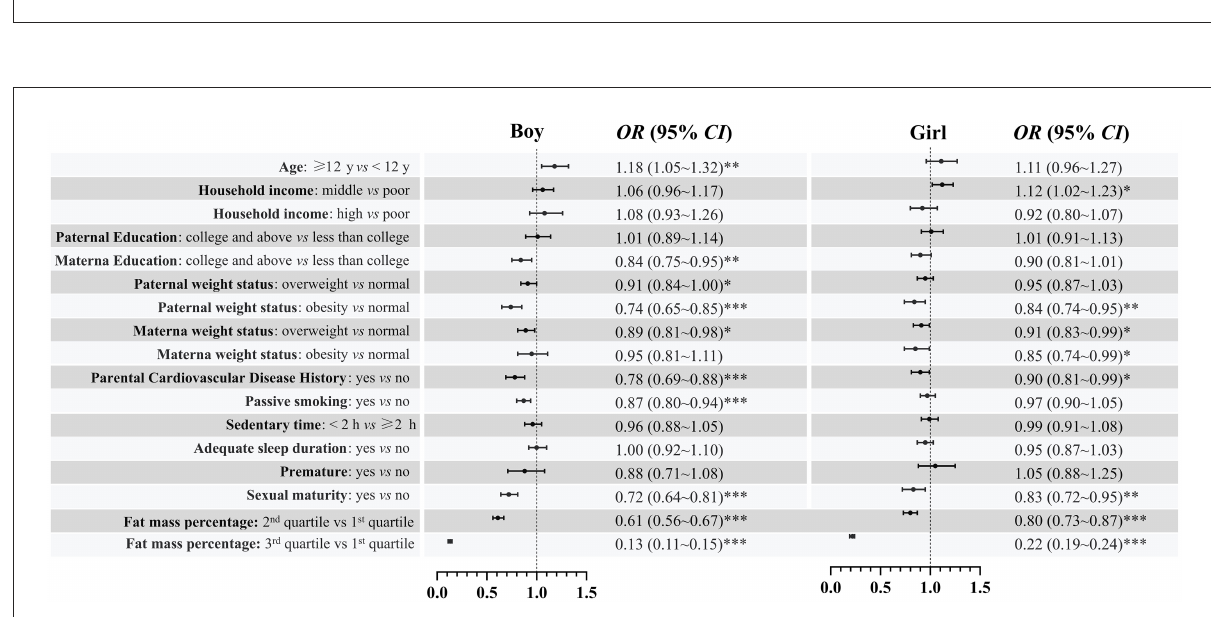
FIGURE4 Association [OR (95%CI)] between demographic factors and ideal cardiovascular health among children and adolescents in Beijing: 2004–2019. *0.01 ≤ P < 0.05; **0.001 ≤ P < 0.01; *** P < 0.001.